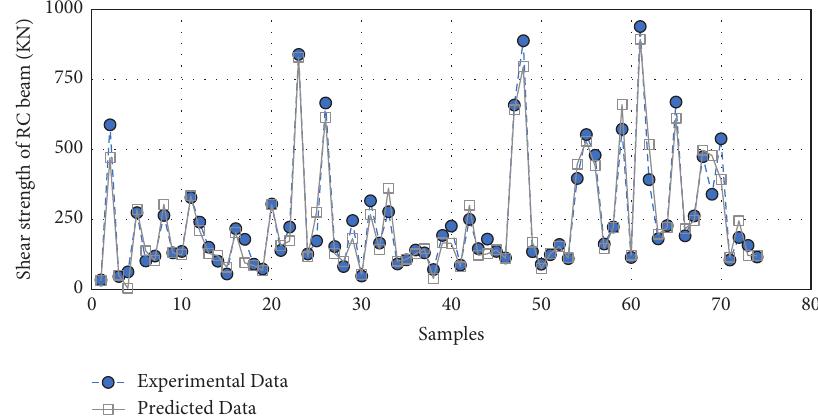
Figure 8: Comparison between the experimental results and ANN-TST 2L (9-5) predictions for testing